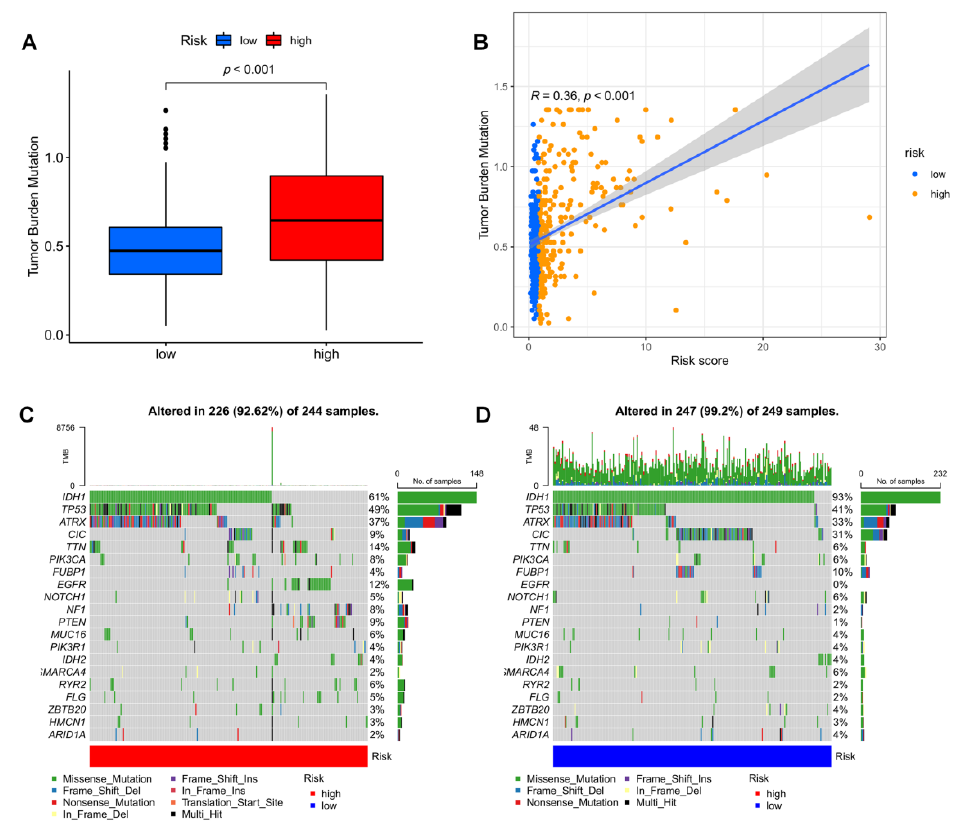
Figure 9. Mutation analysis based on risk score model. ( A ) Differences in TMB in high and low-risk score groups. ( B ) Correlation of risk score and TMB. ( C , D ) Waterfall plots summarizing the mutations in high- and low-risk patients.